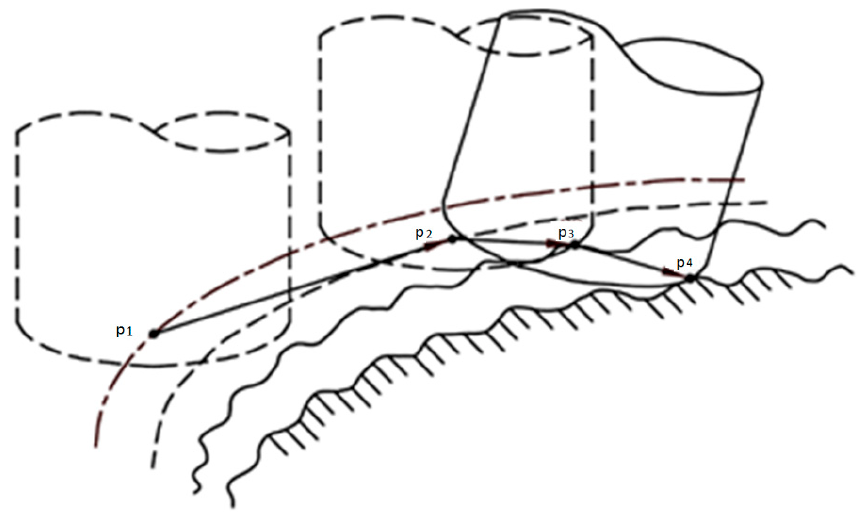
Figure 5. The positional relationship of several CL points.